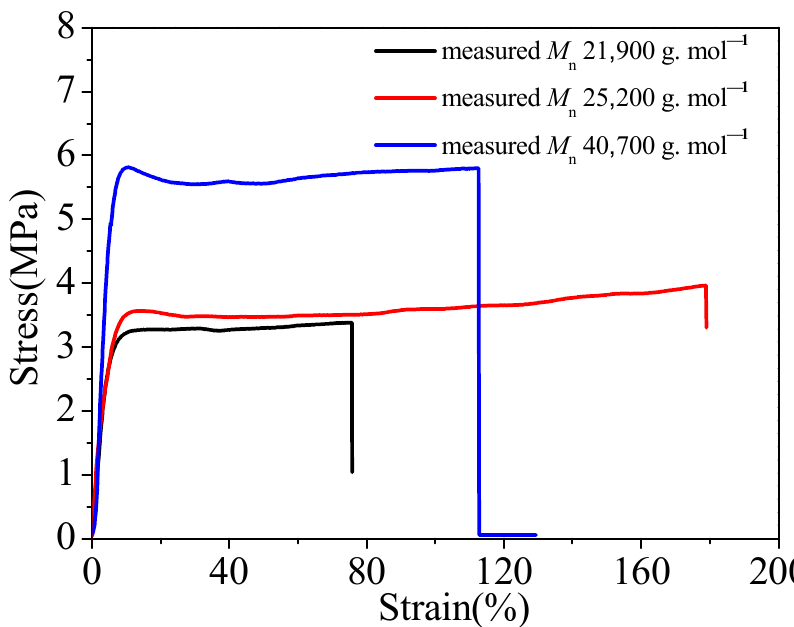
Figure 4. Stress–strain curves of emulsion film with different measured molecular weights.